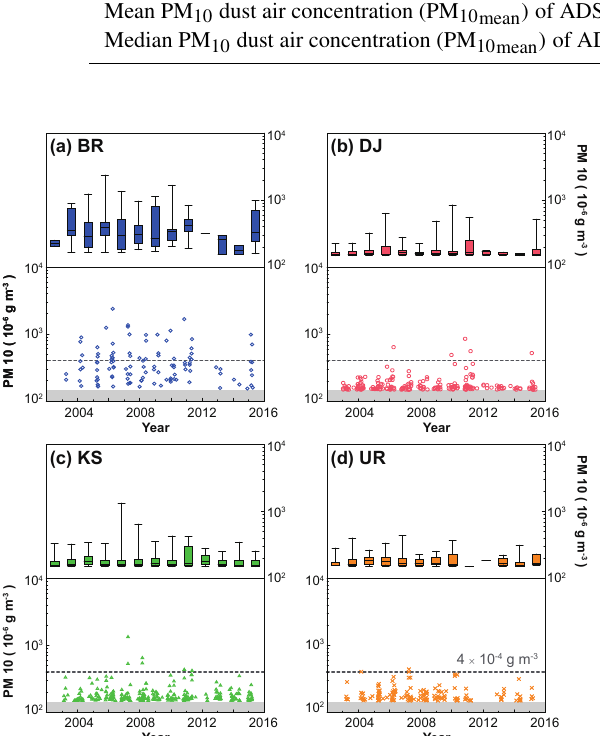
Figure 4. Annual variations of PM 10 dust air concentration at (a) BR, (b) DJ, (c) KS, (d) UR. The lower panel shows a distribu- tion of individual dust air concentration. The upper panel displays box plots for which the central box represents the interquartile of an- nual mean dust air concentration and the whisker lines are extend- ing beyond the maximum and the minimum. In the present study, an individual ADS event was counted as the day with an advisory warning, with PM 10 dust air concentration exceeding 150µgm − 3 per hour. For comparison another reference line was marked for a more significant danger warning with PM 10 dust air concentration exceeding 400µgm − 3 for an hour.